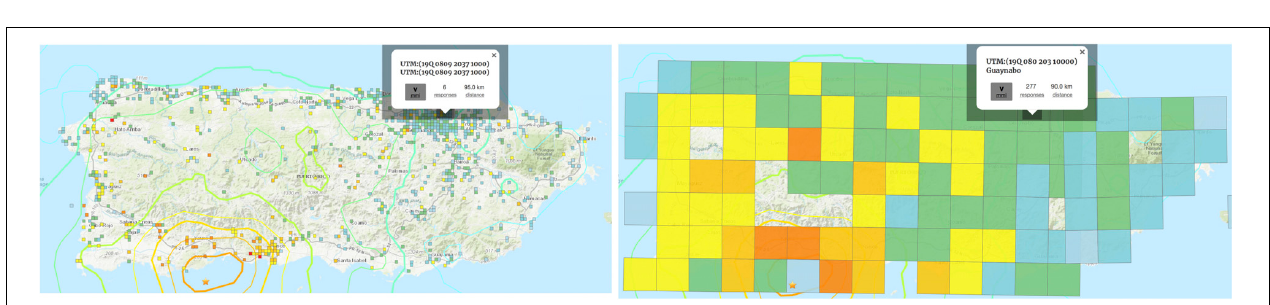
FIGURE 4 | Response rate of DYFI report entries for the M6.4 Indios, Puerto Rico earthquake. For example, scrolling over the curve would show the number of responses at different times. Shown here is the number of responses submitted up to 1 h after the origin time, when nearly 1,200 of 2,200 responses were received (Source: U.S. Geological Survey).